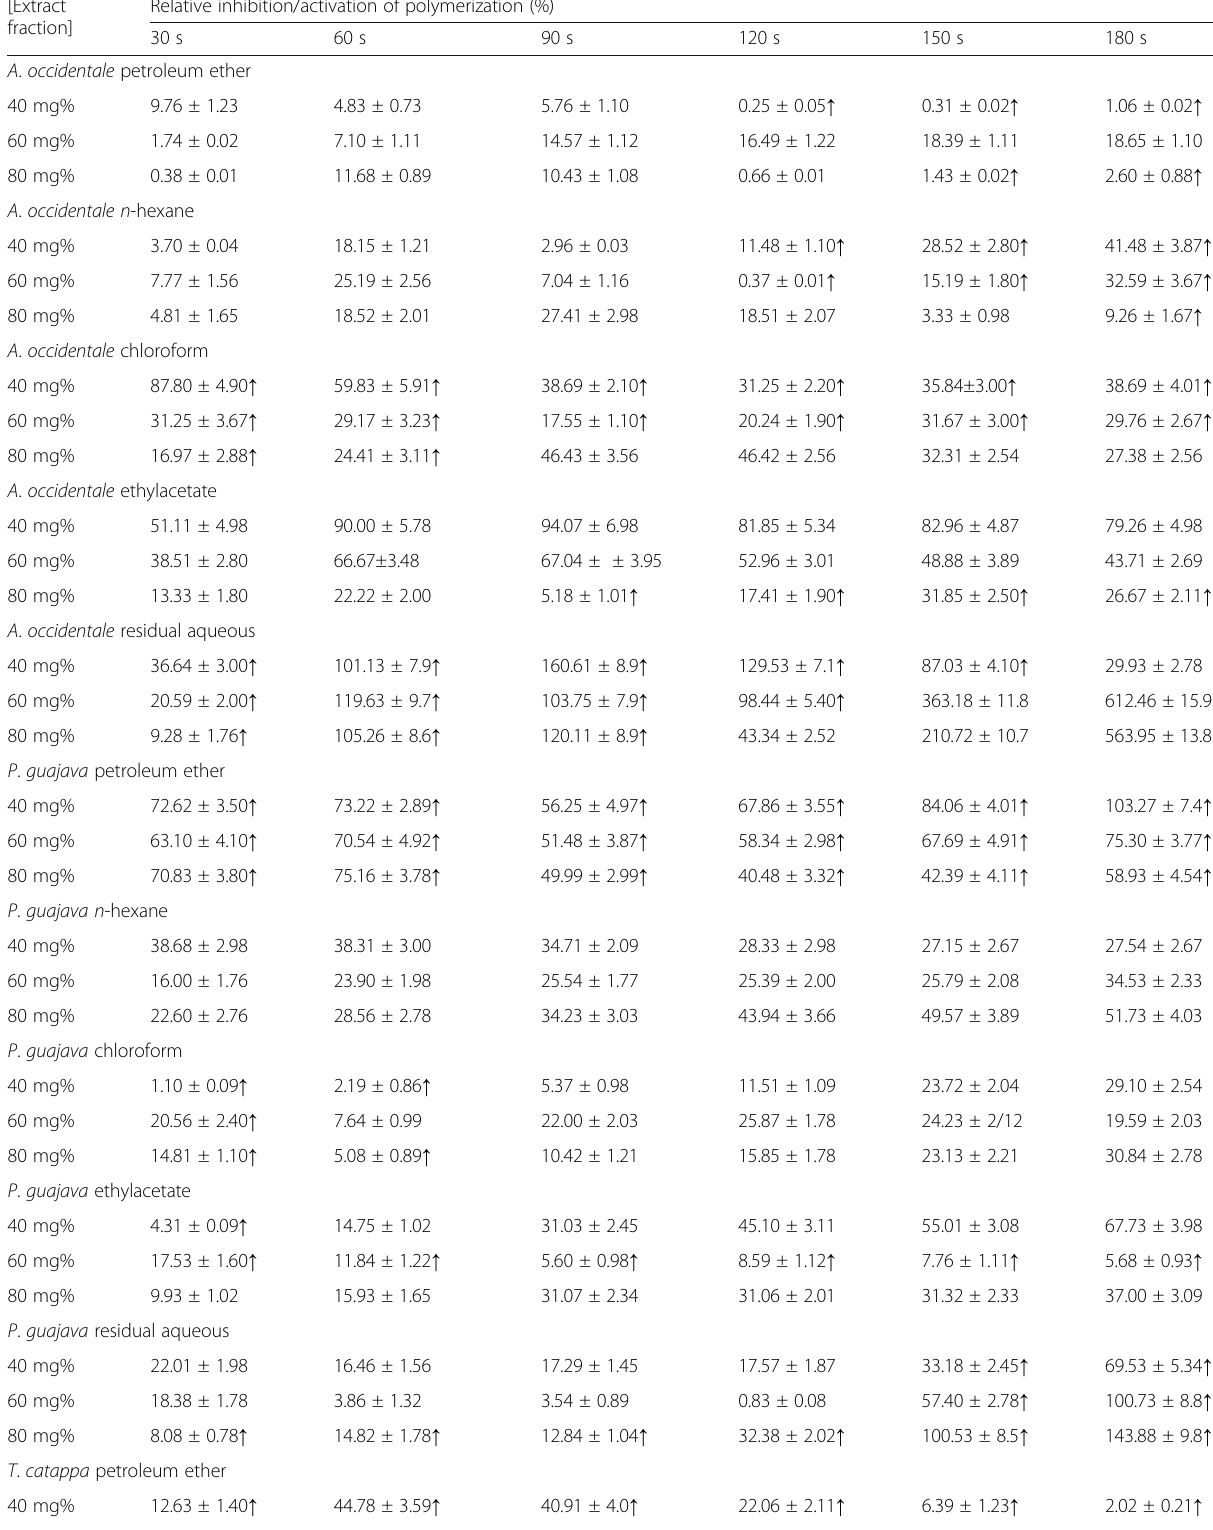
Table 2 Relative levels of inhibition/activation of poly-dHbS-M by fractionated leaf extracts of A. occidentale , P . guajava , and T .